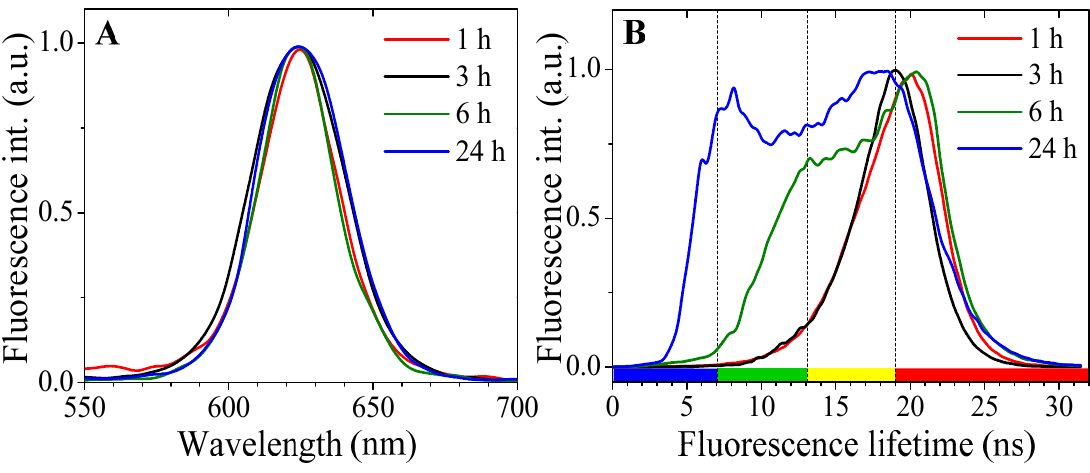
Figure 2. ( A ) Normalized fluorescence spectra of the intracellular vesicles after different QDs incubation times; and ( B ) normalized distribution of mean photoluminescence (PL) lifetimes of QDs localized inside NIH3T3 cells at different time